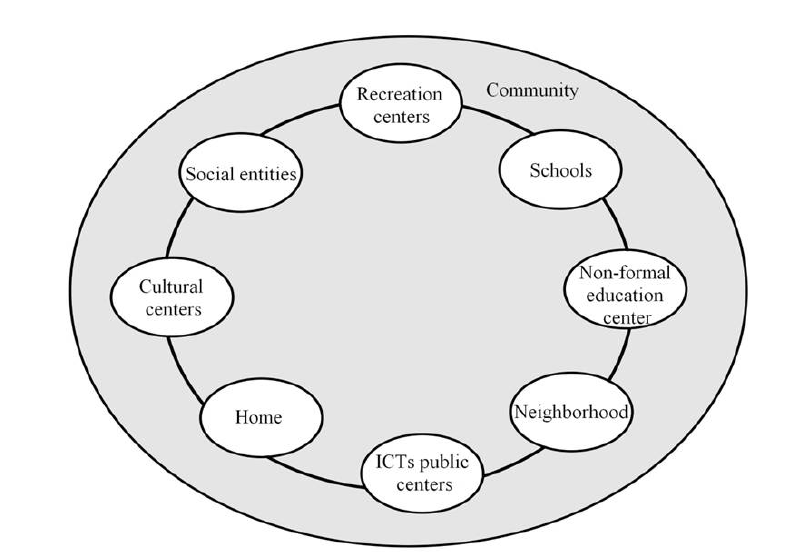
Figure 3. Contexts ofinteraction, learning and development.